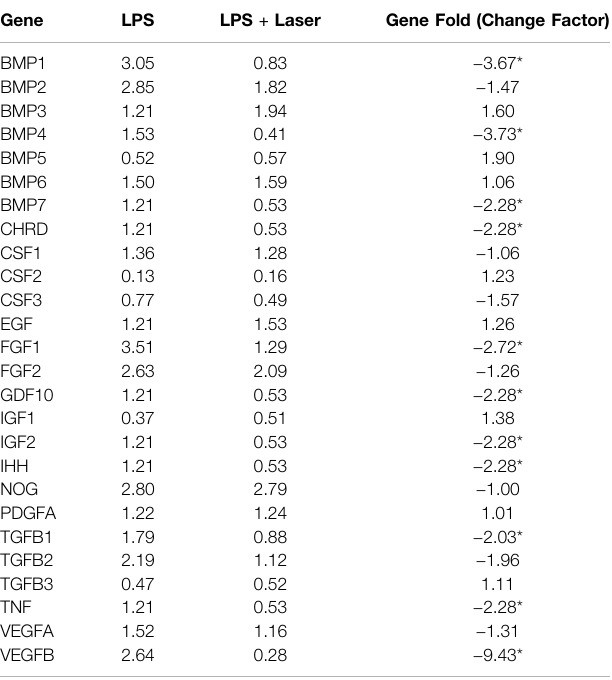
TABLE 3 | mRNA expression of growth and differentiation factors in the DPSCs before and after laser irradiation.